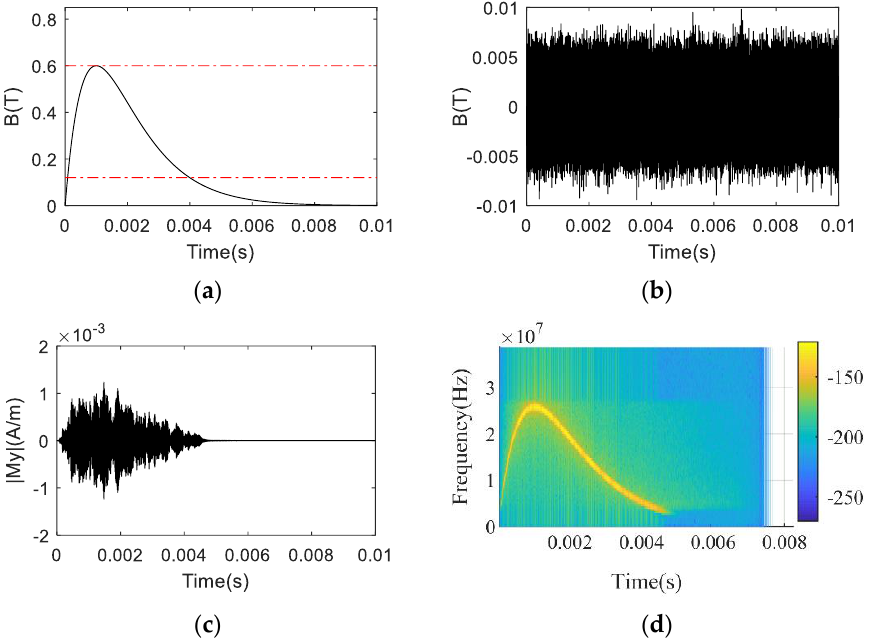
Figure 1. The numerical simulation results: ( a ) The waveform of the pulsed time − varying magnetic field; ( b ) The waveform of the RF excitation signal applied; ( c ) The waveform of the macroscopic magnetization component M y ( t ) ; ( d ) The STFT result of the macroscopic magnetization component M y ( t )